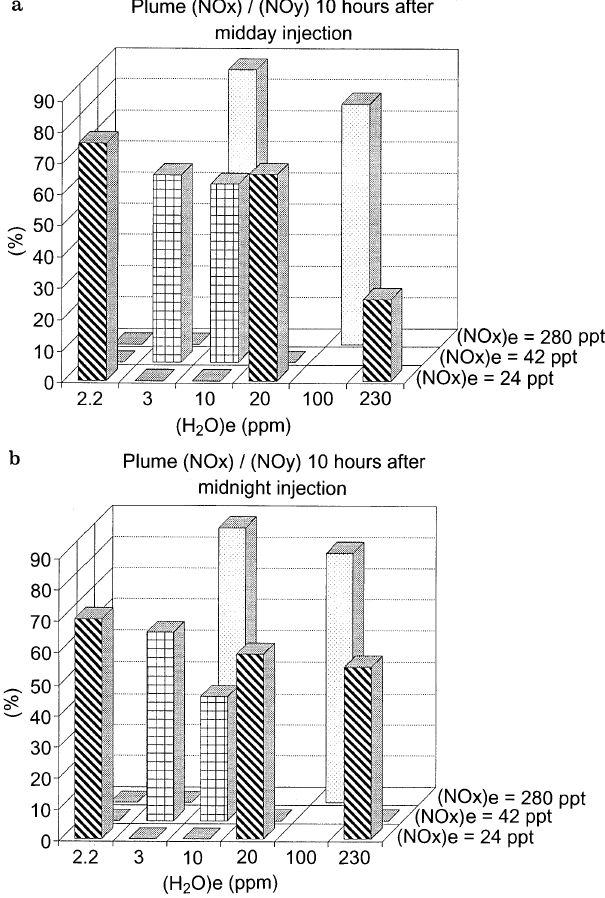
Fig. 11a, b. The box plume (NO (cid:120) )/(NO (cid:121) ) ratio (%) dependence at 10 h after a the midday and b midnight injection from the (H (cid:50) O)